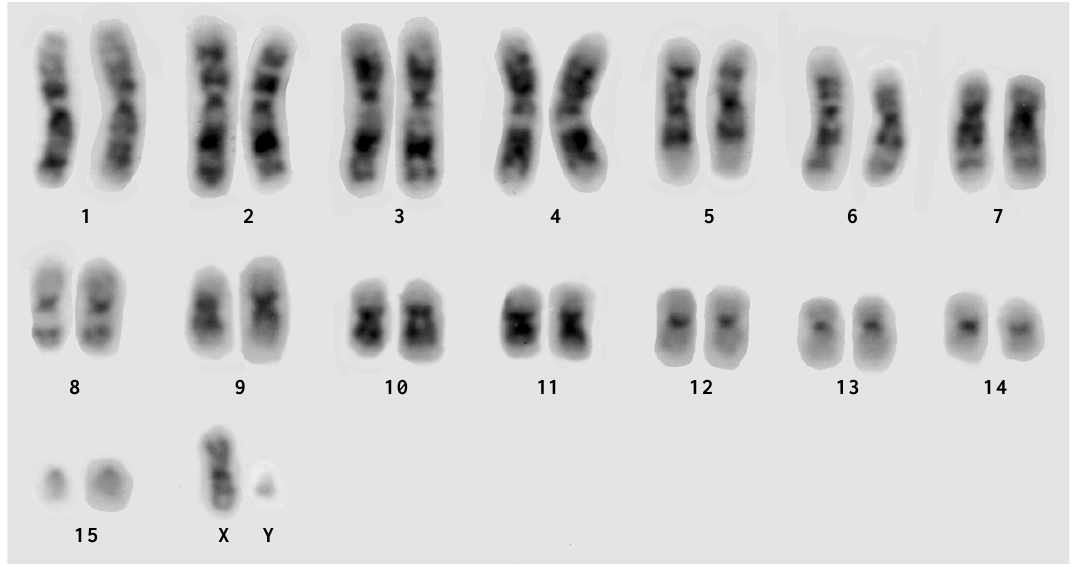
Figure 1 - G-banding pattern of Phyllostomus hastatus